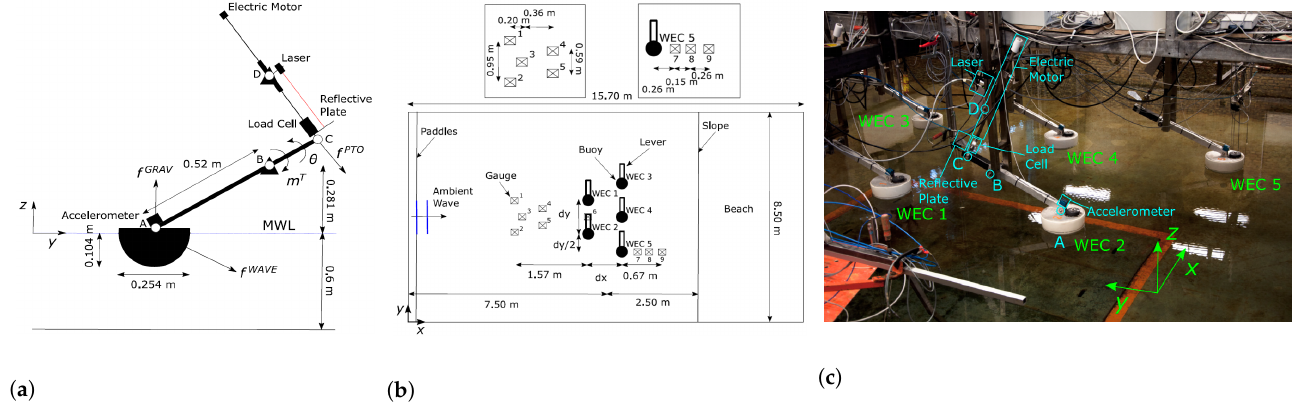
Figure 9. Experimental setup used by Ruíz et al., adapted with permission from Ref. [40], 2017, Ruíz et al.: ( a ) WEC model; ( b ) Aalborg University wave basin WEC array layout; ( c ) Aalborg University’s wave basin